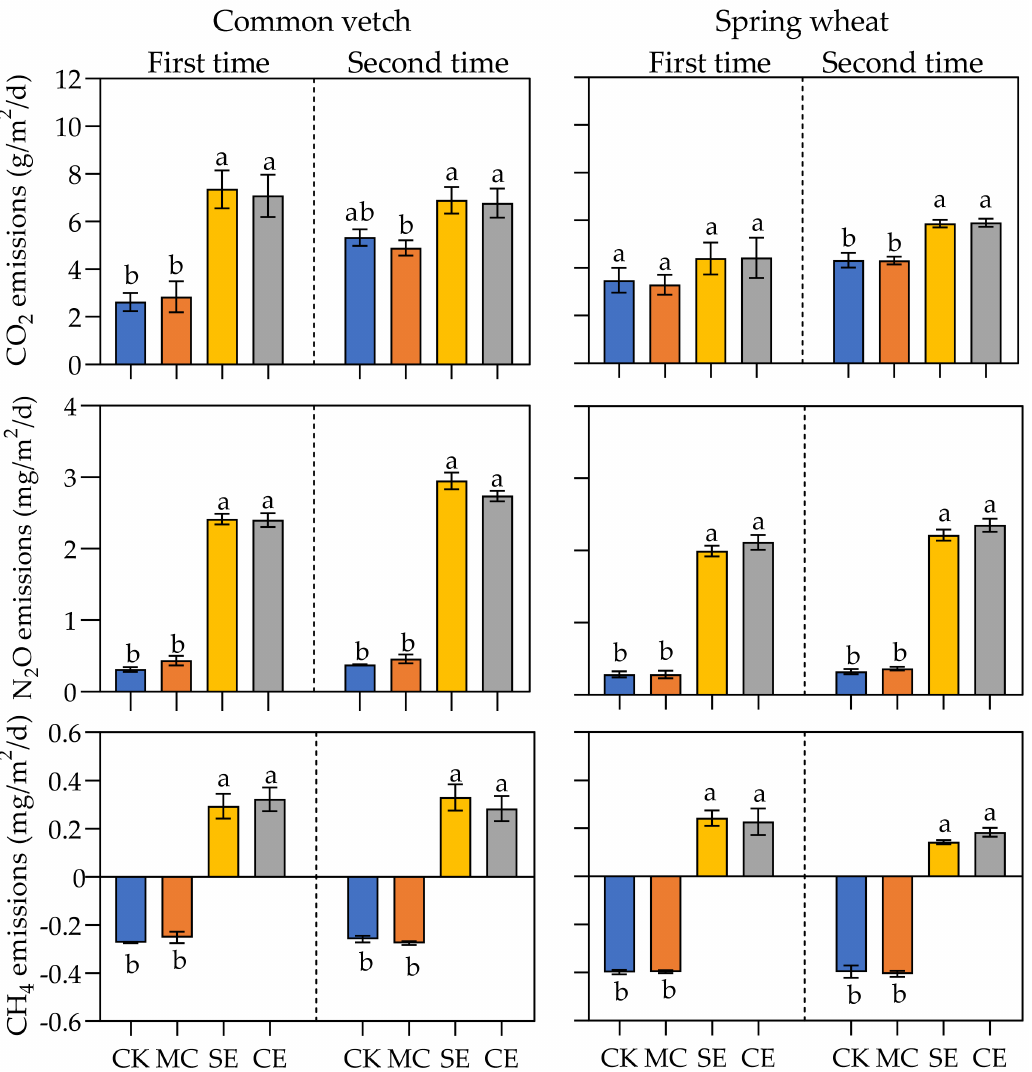
Figure 4. Greenhouse gas (GHG) emissions of two forage crops at two stages. The significant differences were labeled with letters using Duncan’s notation, from largest to smallest: a, b. If there is no significant difference between two values, the same or overlapping letters are used for both